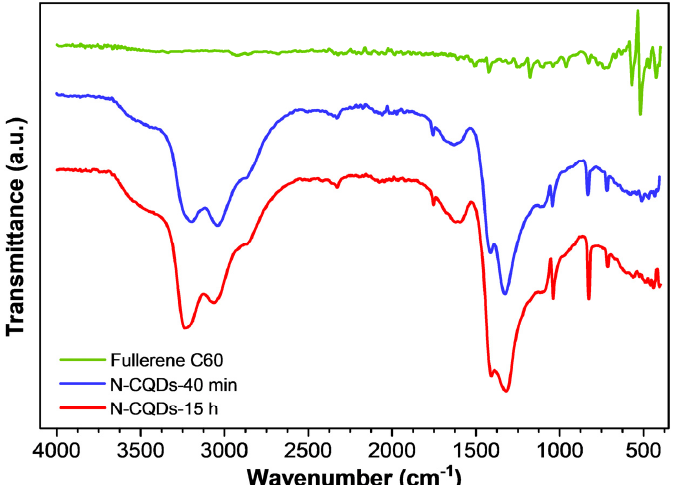
Figure 3. Infrared spectra of fullerene C60 (green solid line), N-CQDs-40 min (blue solid line), and N-CQDs-15 h (red solid line). The samples were deposited on clean Al foil via drop-casting prior to the measurement.